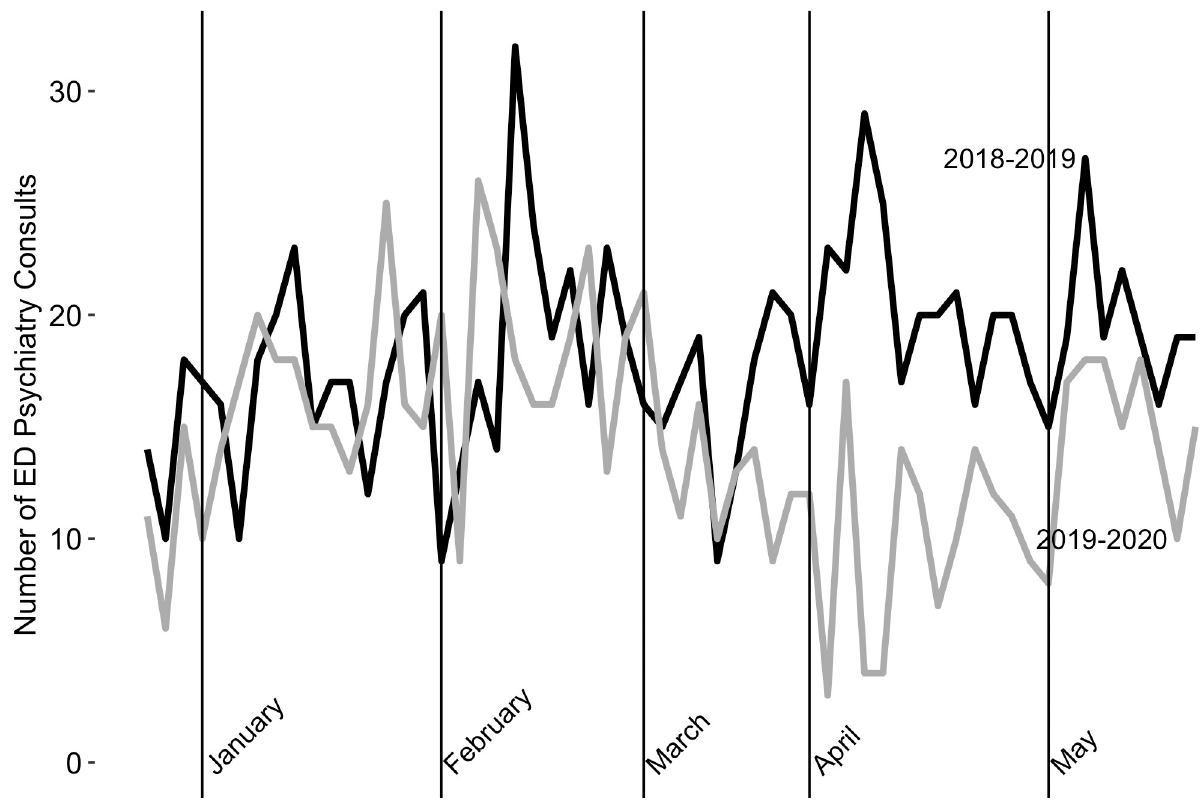
Fig 2. Comparison of unadjusted trends in psychiatry consults between 2019 and 2020